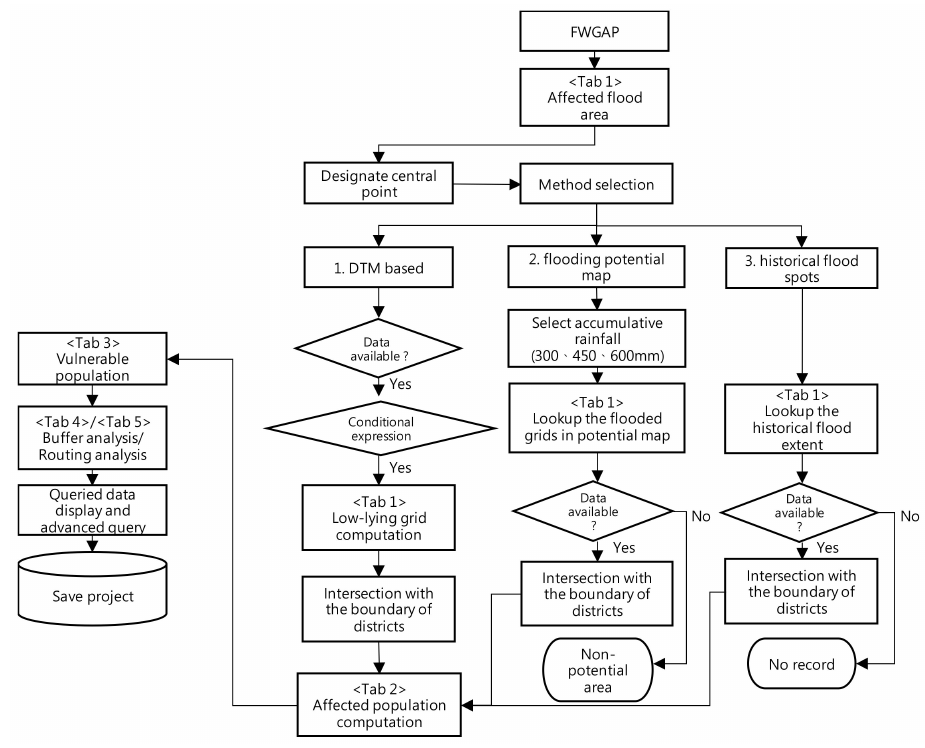
Figure 2. Flow chart of steps in the FWGAP.